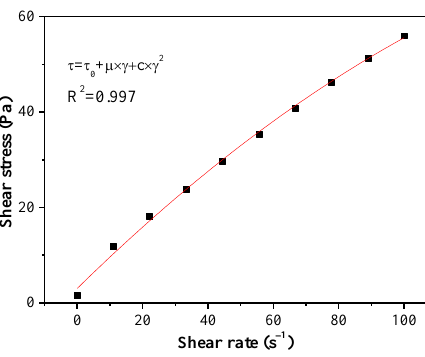
Figure 2. Rheological curves of cement paste samples.